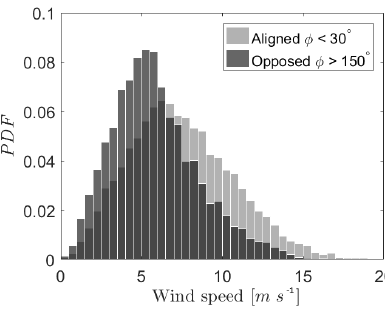
Figure A3. Wind speed probability density function (PDF) for aligned wind–wave direction and opposed wind–wave directions, for the ASIT measurement mast.